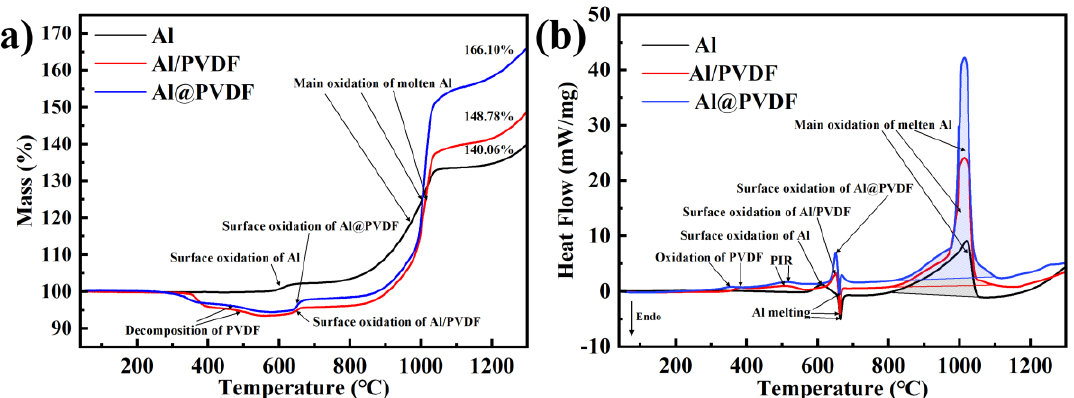
Figure 4. TG and DSC curves of Al powders, Al/PVDF powders, and Al@PVDF powders, ( a ) TG, ( b ) DSC.